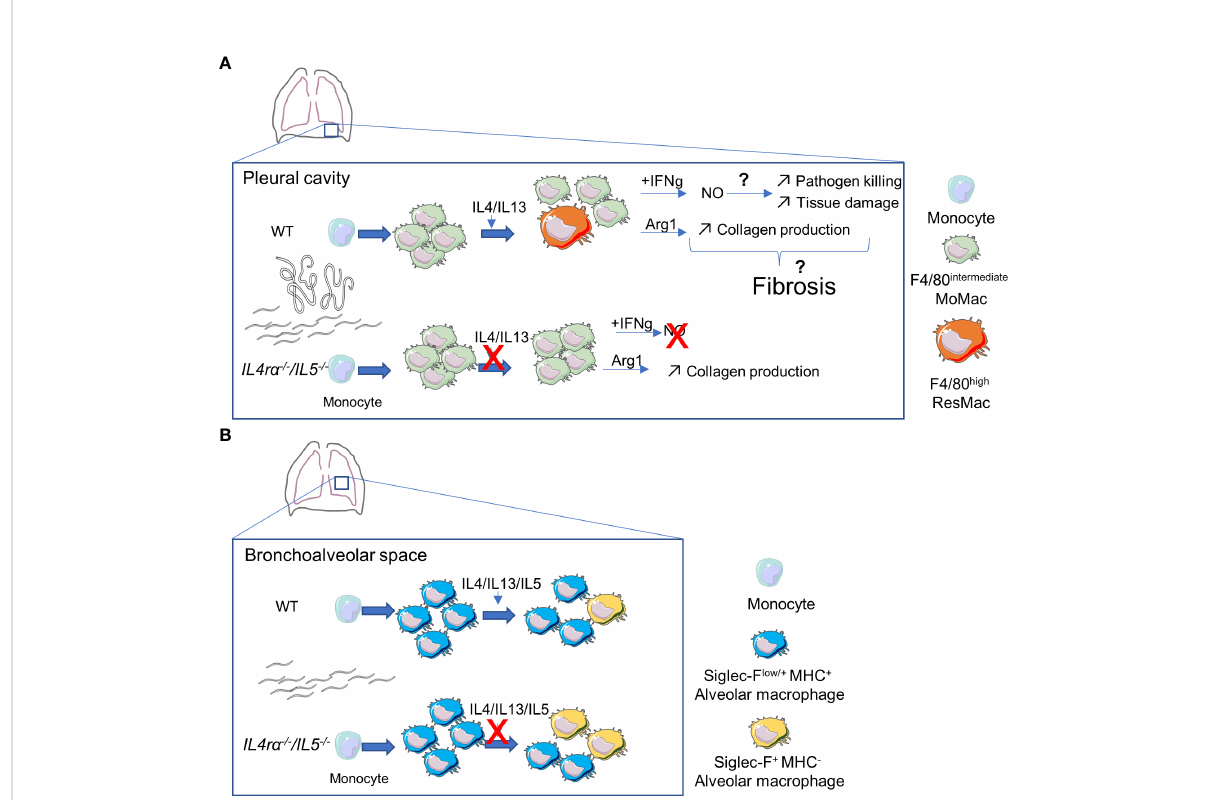
FIGURE 6 Potential effects of altered Th2-immune responses on pleural and alveolar macrophages dynamics and functions during patent Litomosoides sigmodontis infection. (A) In the pleural cavity, adult worms and micro fi lariae induce a strong recruitment of F4/80 intermediate Monocyte-derived macrophages (MoMac). Some of them will then mature into F4/80 high resident macrophage (ResMac) in an IL4R-dependent manner. Macrophages acquire an IL4R-driven alternative activation state and increase Arginase1 (Arg1) expression and activity. This might lead to increased proline availability and collagen production in the cavity. On the other hand, pleural macrophages upregulate IFNgR1 and in the presence of IFN g , macrophages produce nitric oxide (NO). NO could then favor pathogen killing but also tissue damage. Together, tissue damage and increased collagen could favor tissue fi brosis. In the absence of IL4-receptor and IL5, MoMac are still recruited but fail to mature into ResMac. IFNgR1 expression is not upregulated leading to an unresponsiveness to IFN g impairing NO production. Arg1 expression is not affected and its activity is increased compared to WT mice, but, maybe because of the absence of tissue damage, this is not suf fi cient to initiate tissue fi brosis. (B) In the bronchoalveolar space, monocyte-derived Siglec-F low/+ MHC + alveolar macrophages seem to repopulate the Siglec-F + MHC - bona fi de alveolar macrophage population. In the absence of Th2-immune responses and eosinophils, the maturation of these transient macrophages could be